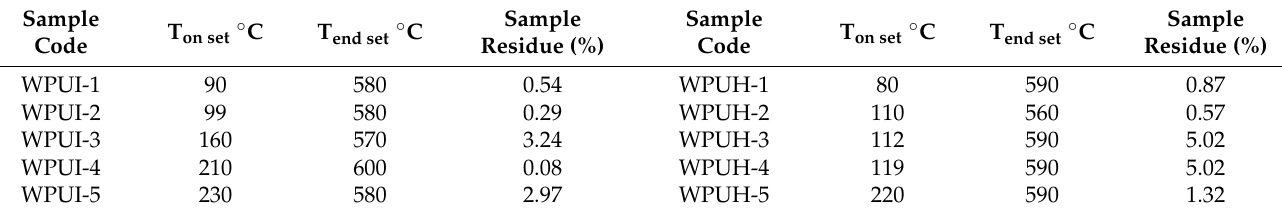
Figure 3. Thermogravimetric analysis of WPUDs: ( A ) WPUI series and ( B ) WPUH series. Table 2. Thermal analysis of WPUI and WPUH